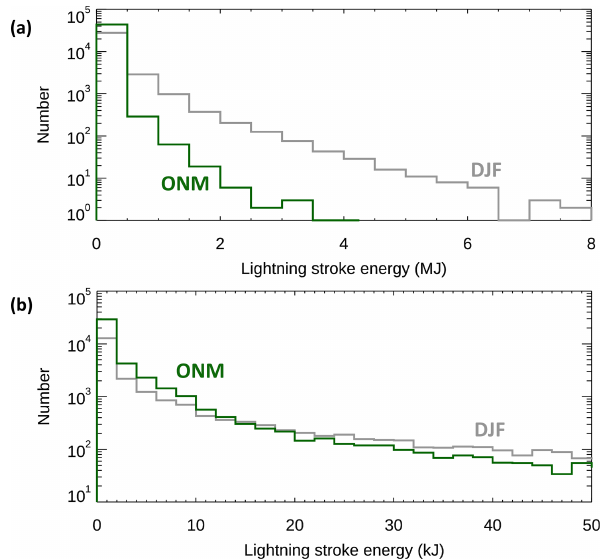
Figure 2. (a) Histogram of energies of all lightning strokes detected by WWLLN during winter 2014–2015 in the North Atlantic region. The bin size is 500kJ, plotted separately for DJF (grey) and ONM (dark green). (b) A detailed view of the weakest part of the stroke energy distribution with a bin size of